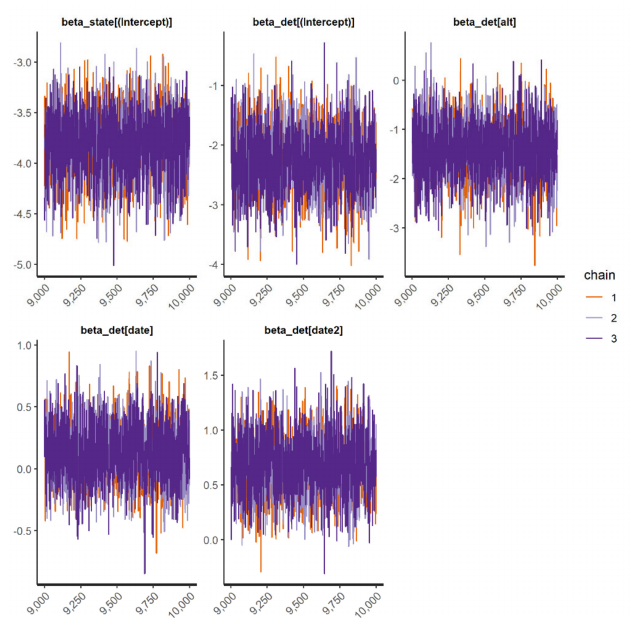
Figure A11. Traceplots from the best occupancy model ( ψ (intercept); ρ (intercept + elevation + Julian day + Julian day2)) of house sparrow ( Passer domesticus ) in Puerto Rico. Note: alt = elevation; date = Julian date (we considered Julian day 1 as the first day of a device starting to record in the field, which was 1 March 2021); date2 = square of Julian date.